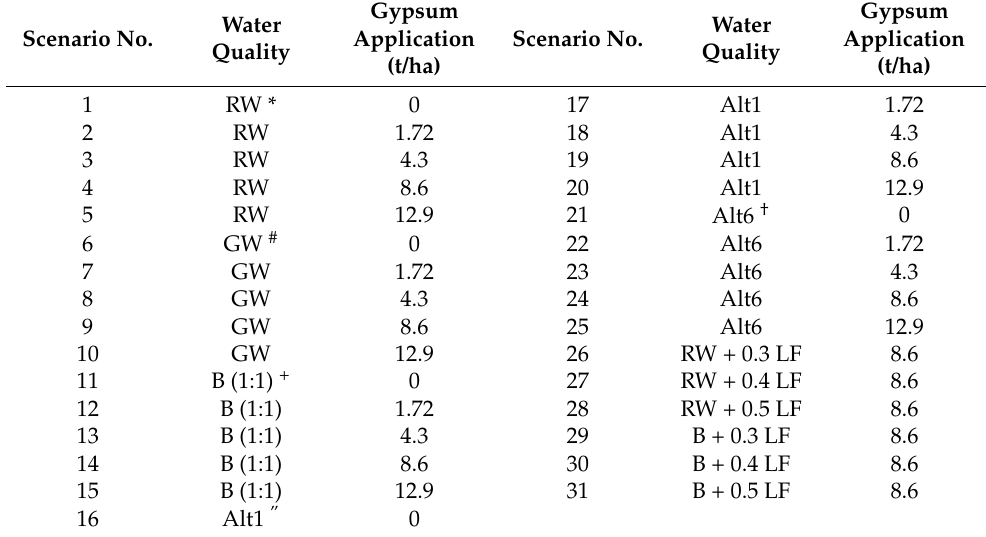
Table 2. Different water quality and gypsum application scenarios performed for the hard red-brown (HRB) soils under